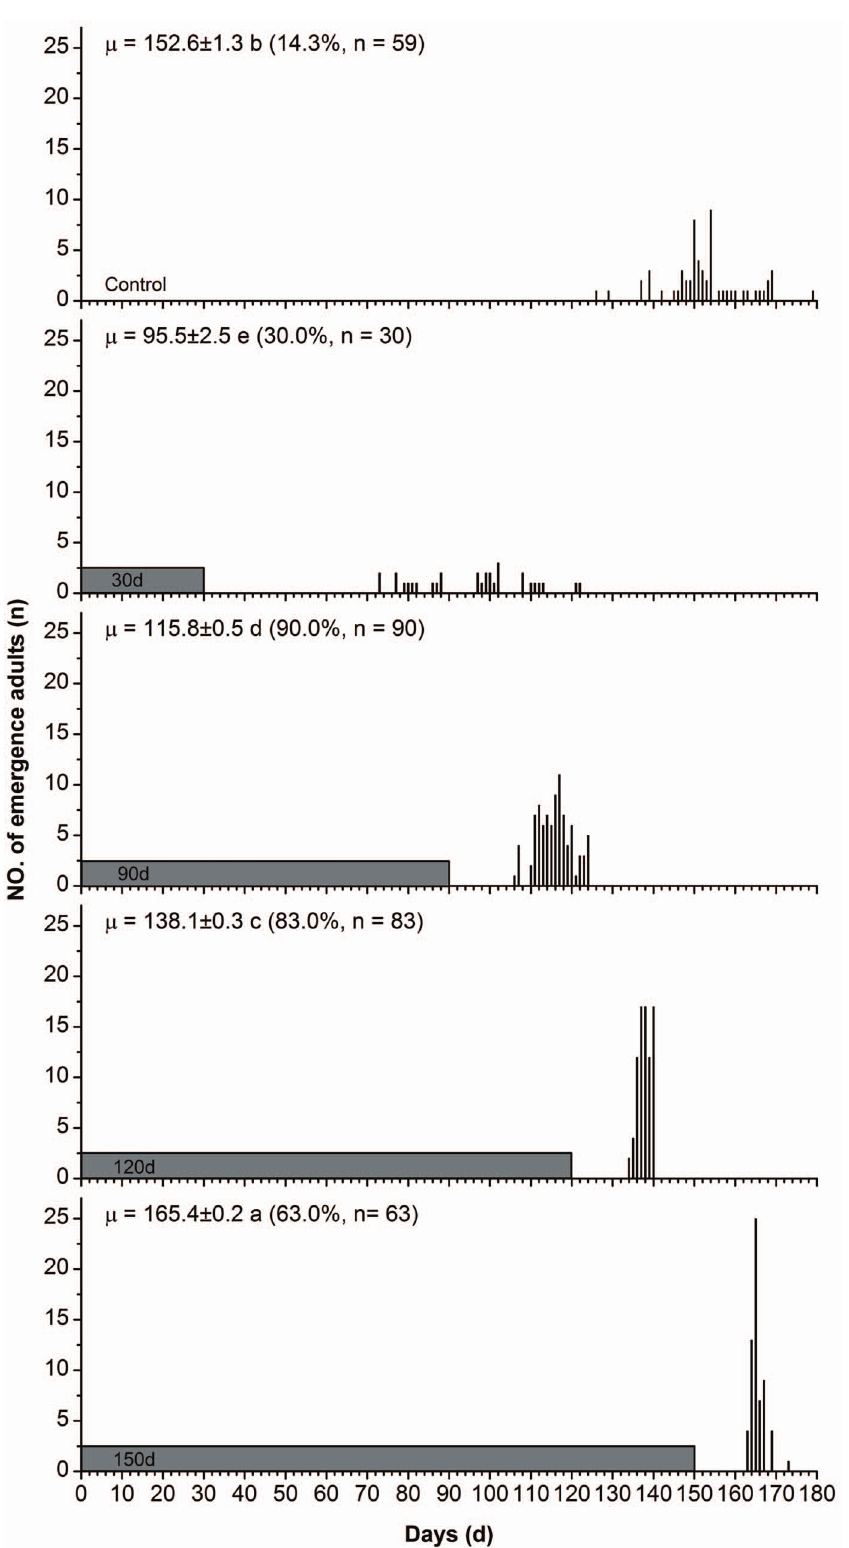
Figure 5. Frequency distribution of adult eclosion in diapausing pupae of H.cunea . The diapausing pupae were transferred to LD 15:9 at 25 u C after exposure to 5 u C and DD for different numbers of days. The hatched bar indicates the period of cold exposure. Values followed by different letters are significantly different by Tukey’s multiple comparisons ( P , 0.05). Values in parentheses are survival rates after diapause and numbers of adults emerged from diapausing pupae.